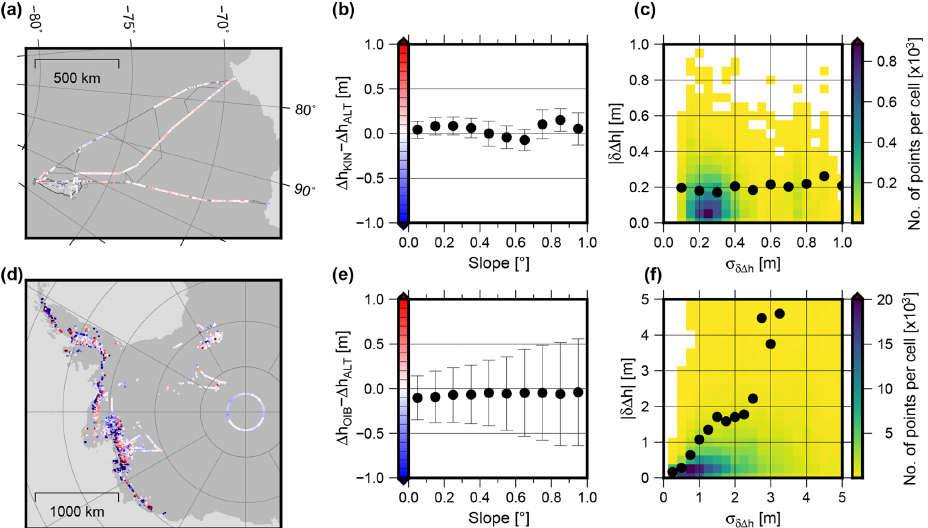
Figure 7. Validation with elevation differences observed by kinematic GNSS between 2001 and 2015 (a, b, c) and Operation IceBridge between 2002 and 2016 (d, e, f) . Differences between elevation changes observed by the validation data and altimetry are shown in the maps ( a, d , color scale in panels b and e ). Median and MAD of these differences, binned by different surface slope, are shown in the center (b, e) . The right diagrams (c, f) show the comparison of these differences with the respective uncertainty estimate, obtained from both data sets. The point density is plotted from yellow to blue and the black dots show the root mean square, binned against the estimated